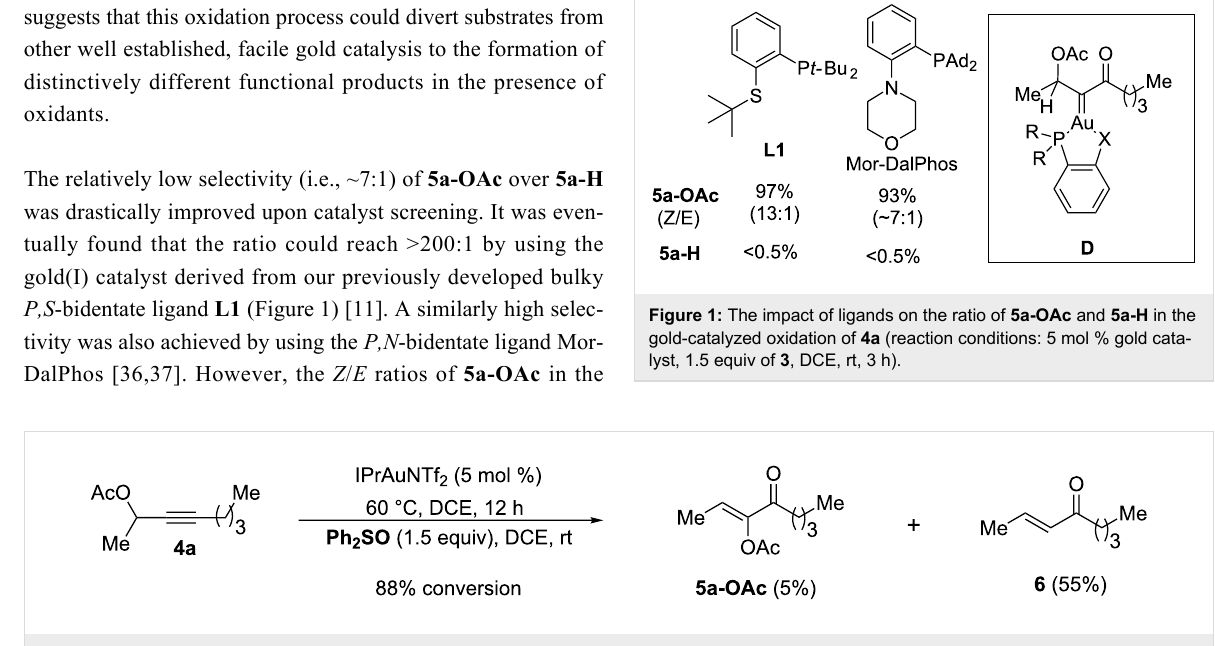
enone 6 (56% yield, 88% conversion) due to a dominant gold- catalyzed 3,3-rearrangement; c) this alternative could not ratio- nalize the formation of 5a-H .